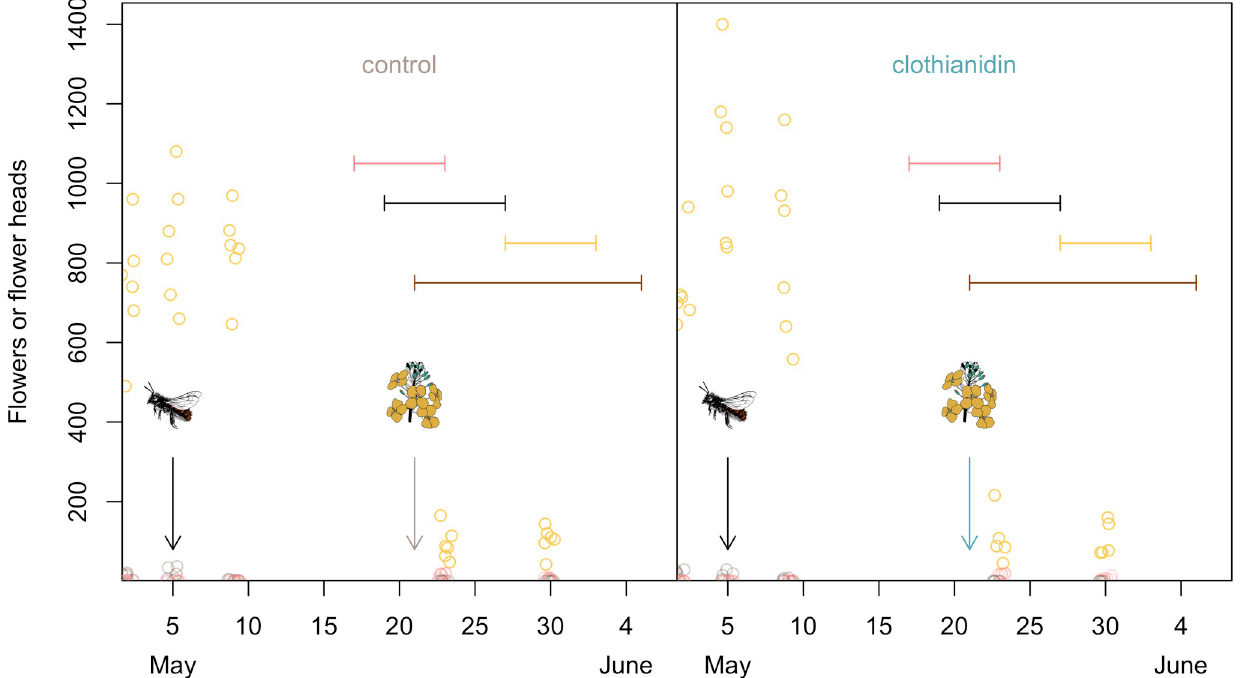
Fig 1. The circles indicate the number of open rapeseed (yellow) and strawberry (red) flowers, or flower heads of dandelion (brown), which we measured in all the cages on the 2 nd , 5 th , 9 th , 23 rd and 30 th May. The vertical arrows indicate the day when we manually released the females that had not emerged from their cocoons (black) and the day when two untreated (beige) or treated (turquoise) spring-sown rapeseed plants were added to cages. The horizontal solid lines indicate the periods during which data were collected for flower-visitation of strawberry plants (red), entire foraging trips (black) and ten visits to rapeseed flowers (yellow). The brown horizontal line indicates the period, during which we observed new nest plugs